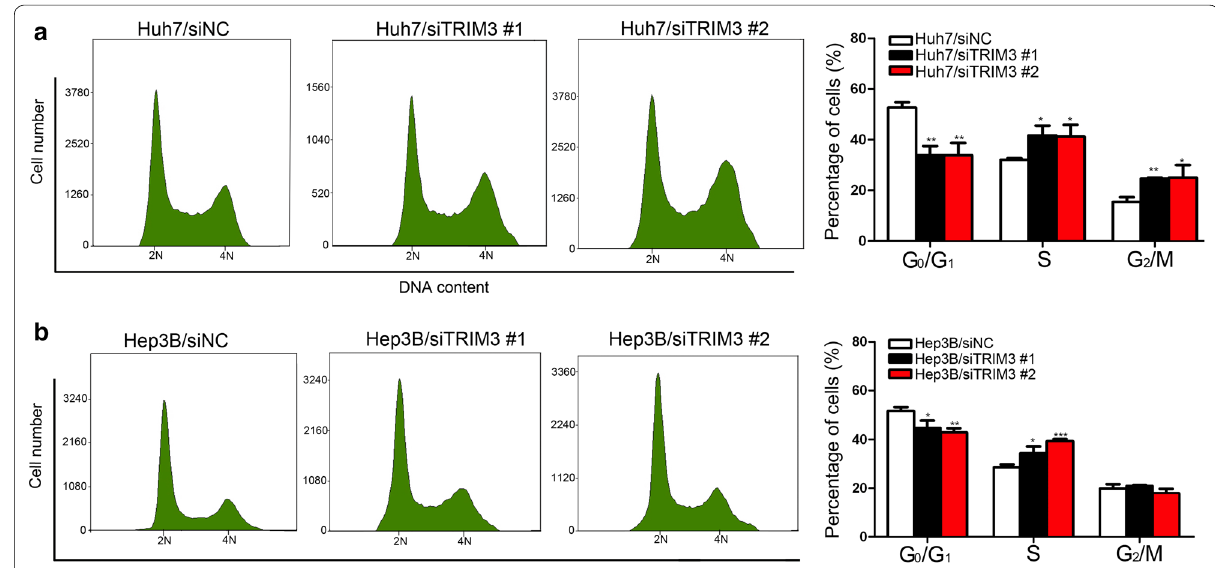
Fig. 5 Effects of TRIM3 silencing on the cell cycle of Huh7 and Hep3B cells. The cells were collected for cell cycle distribution analysis with flow cytometry after they were transfected with siTRIM3 or siNC for 48 h. The percentages of cells in the G 0 /G 1 phase were significantly decreased in Huh7 ( a ) and Hep3B ( b ) cells transfected with siTRIM3. P values were calculated using Student’s t test. * P < 0.05, ** P < 0.01, and *** P < 0.001, versus cells transfected with